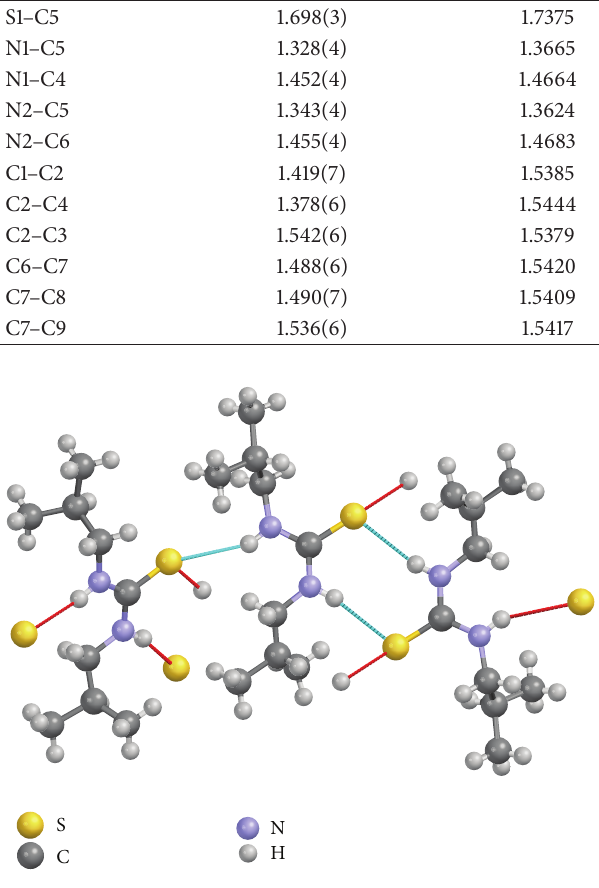
Figure 2: The packing of thiourea ( 1 ) molecules showing the intermolecular H-bonding.